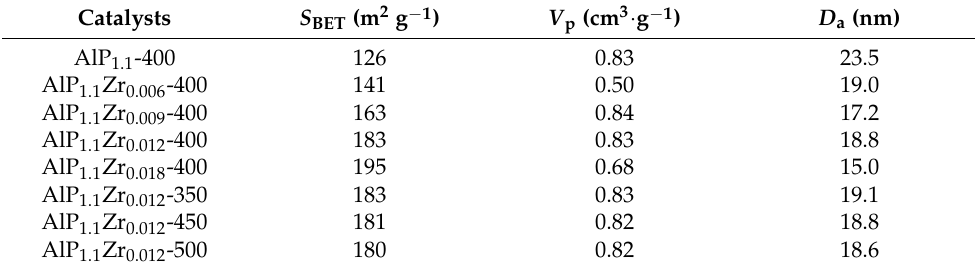
Table 1. Physical properties of AlP 1.1 Zr x - T catalysts.